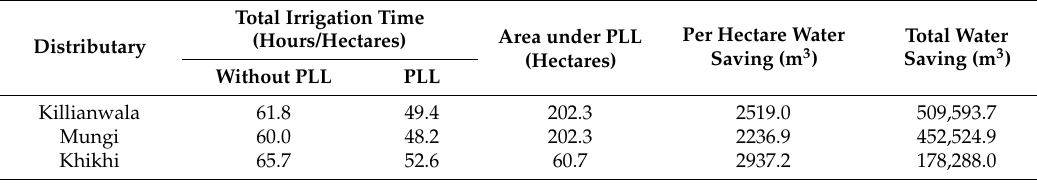
Table 3. Water savings from cotton under PLL.